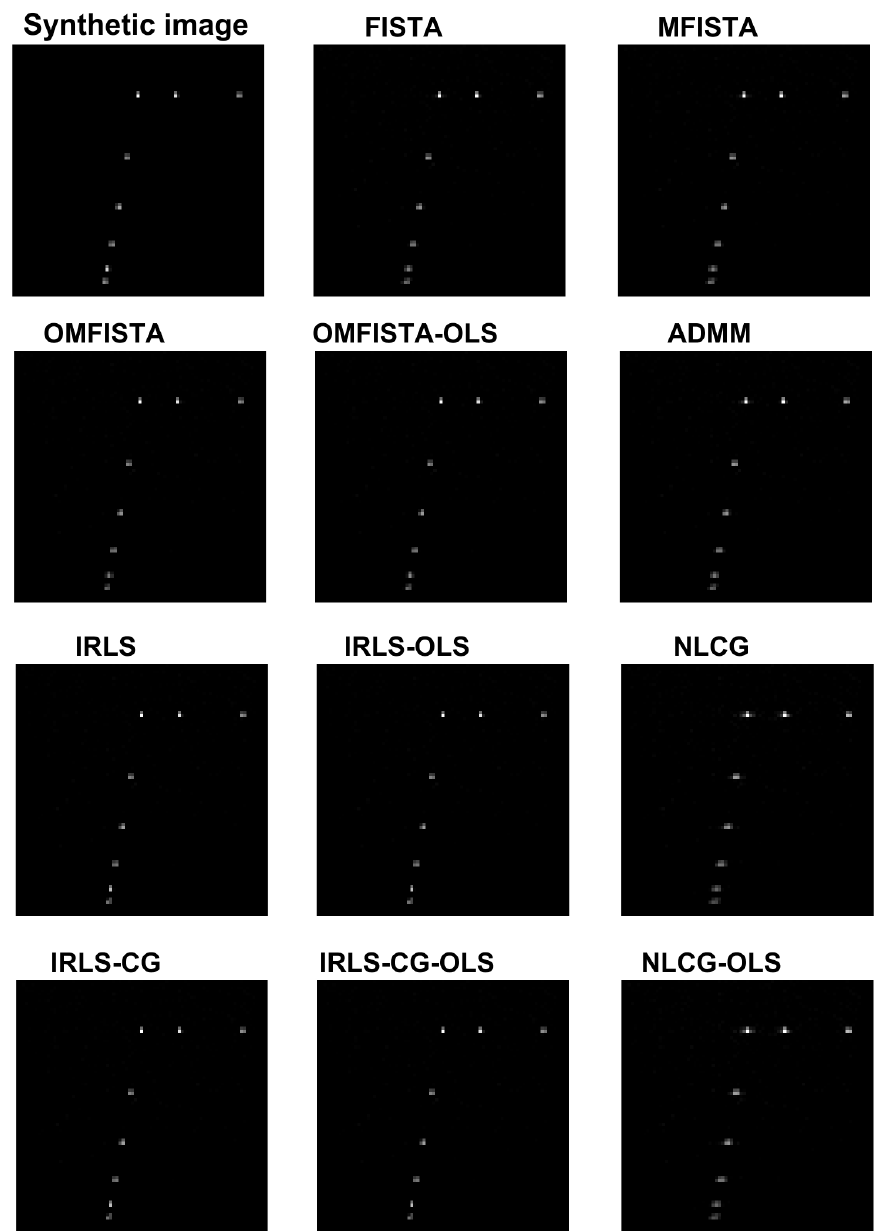
Figure 12. Reconstructed images from the synthetic